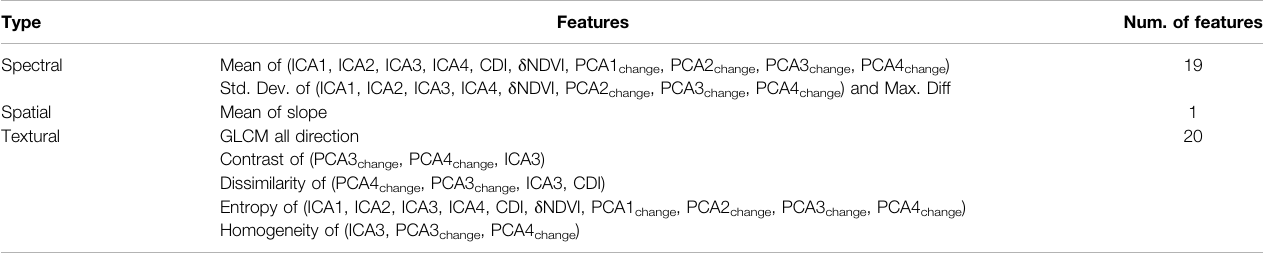
TABLE 2 | Selected image object features used for the change-based dataset.